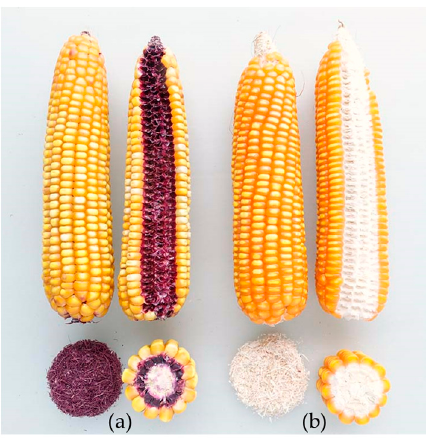
Figure 2. Comparison of purple husk and cob of ( a ) purple field corn and ( b ) white husk and cob of normal field corn.